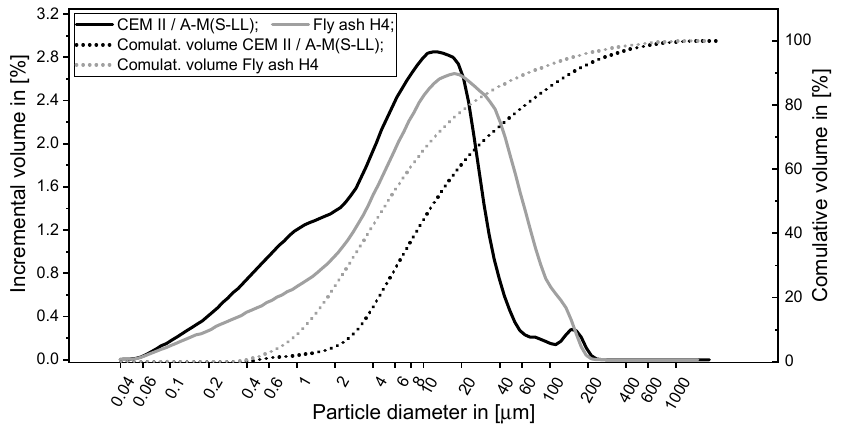
Figure 3. Particle size distribution of the solid constituents.